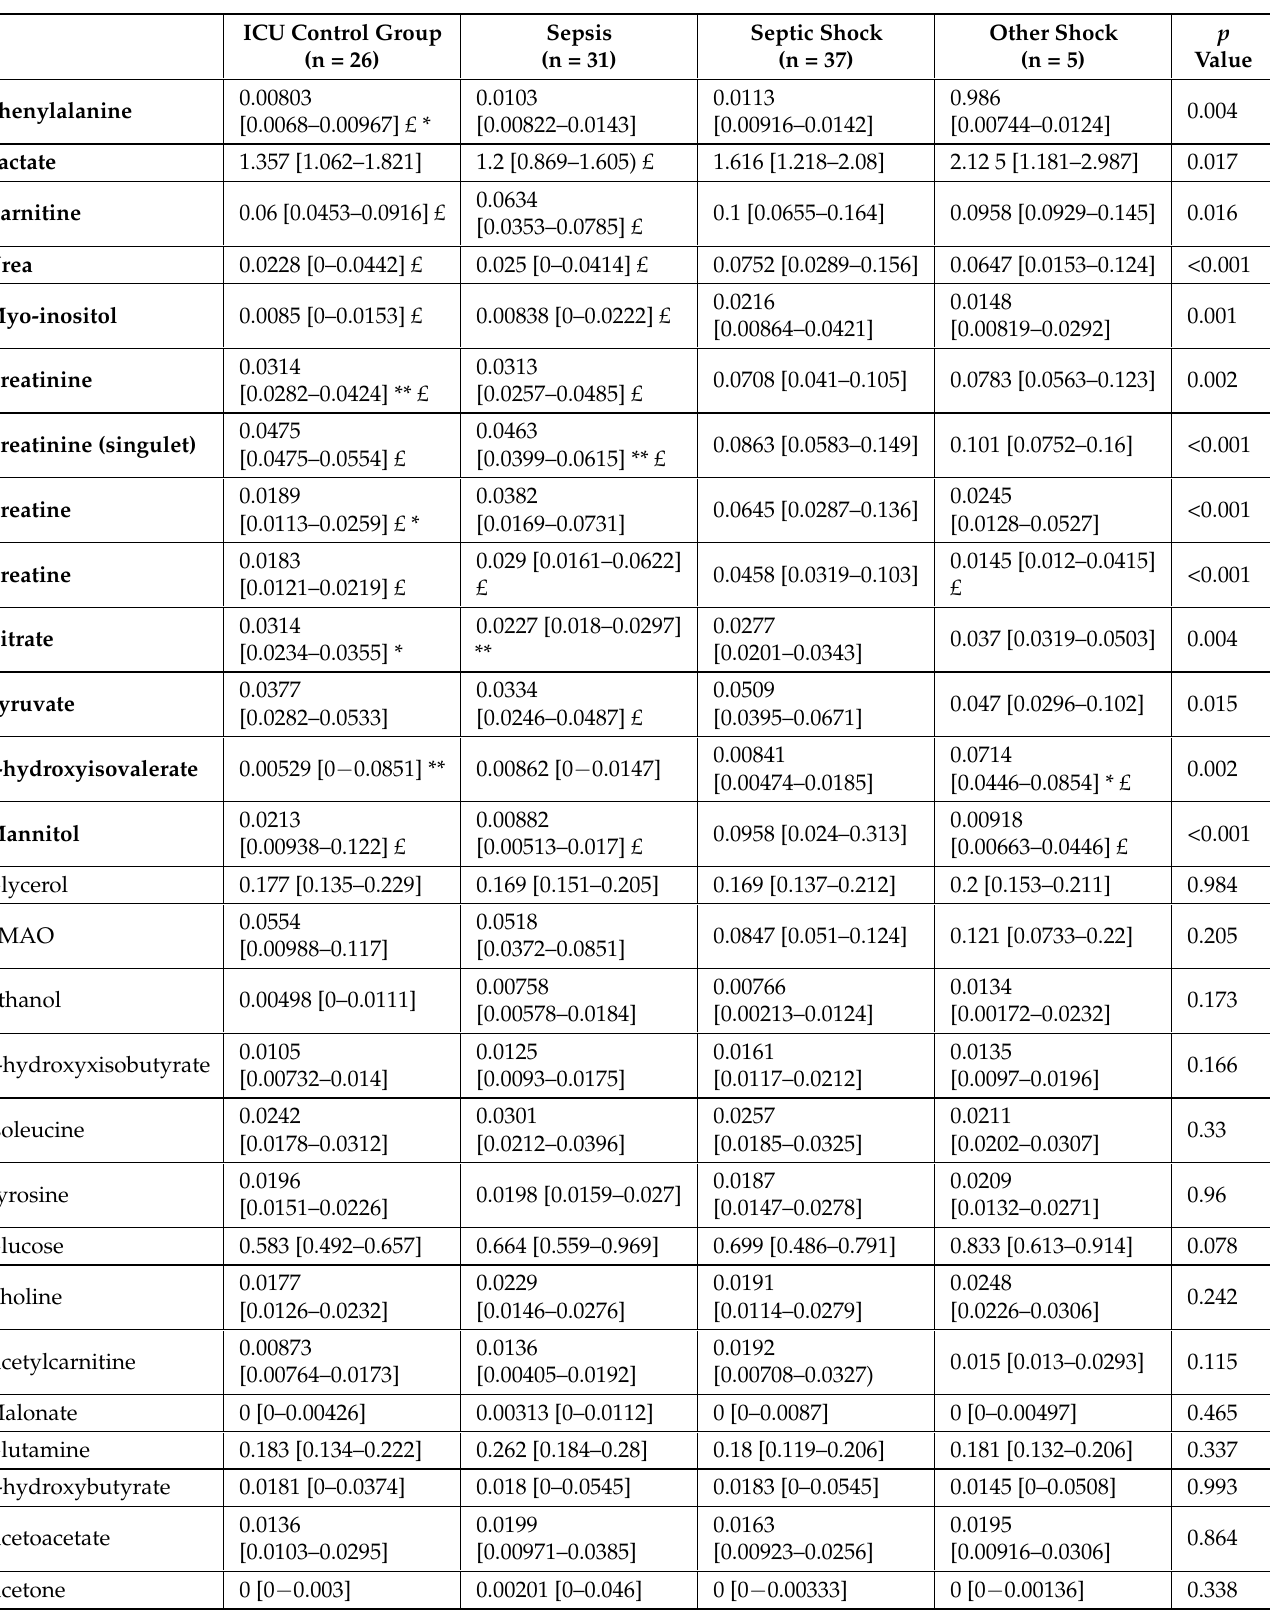
Table 5. Comparisons of the area under the curve (AUC) values for several metabolic products in the four patient